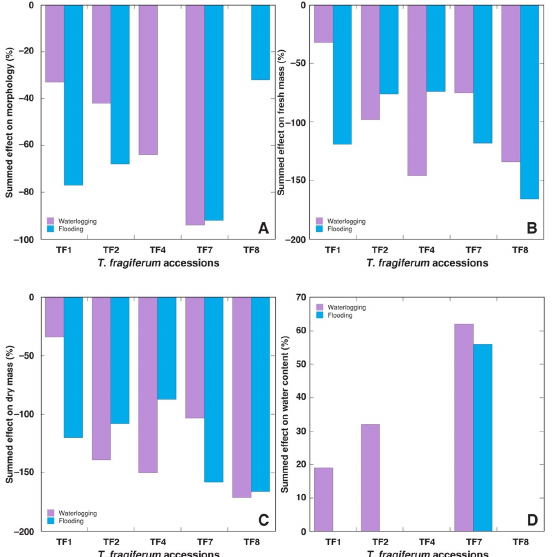
Figure 4. Summed effect of increased soil moisture in the form of waterlogging and flooding on morphology ( A ), fresh mass of plant parts ( B ), dry mass of plant parts ( C ), and water content in plant parts ( D ) of Trifolium fragiferum plants of different accessions. Measurements were performed after three weeks of treatment plus four weeks of recovery. Only statistically significant effects are taken into the account.